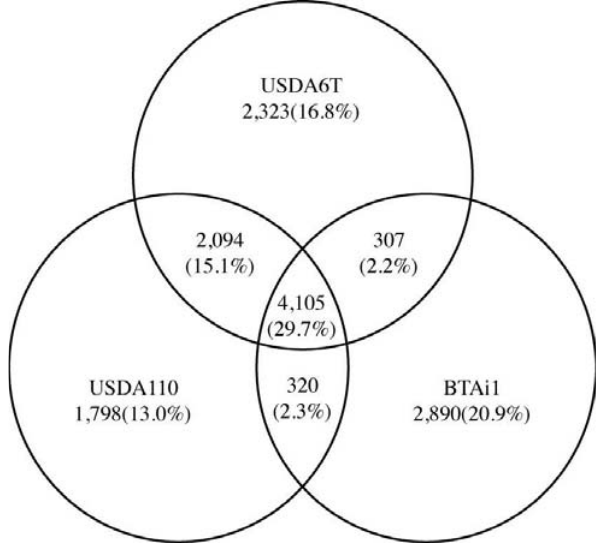
Figure 5. Comparative genomic analysis among three strains: USDA6 T , USDA110, and BTAi1. The total non-redundant number of deduced proteins from the three strains is 13,837. The number of proteins per genome is given inside the circles representing the bacterial strains. The overlapping sections indicate shared numbers of proteins. The proportion of the entire protein number is shown in